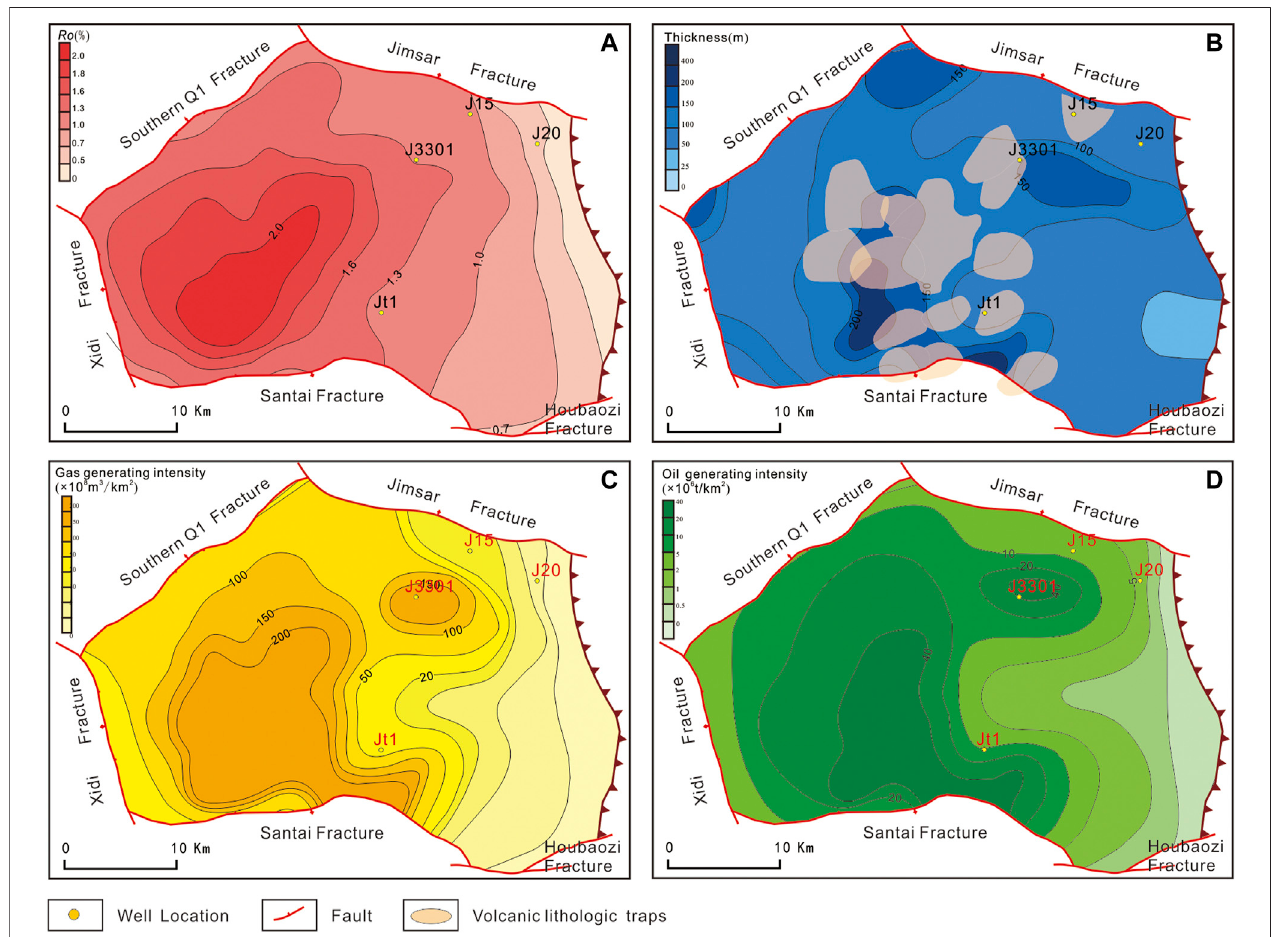
FIGURE 5 | The contour map of (A) R o , (B) thickness, (C) gas-generating potential, and (D) oil generating potential for C 1 s b source rocks in the Jimsar Sag.